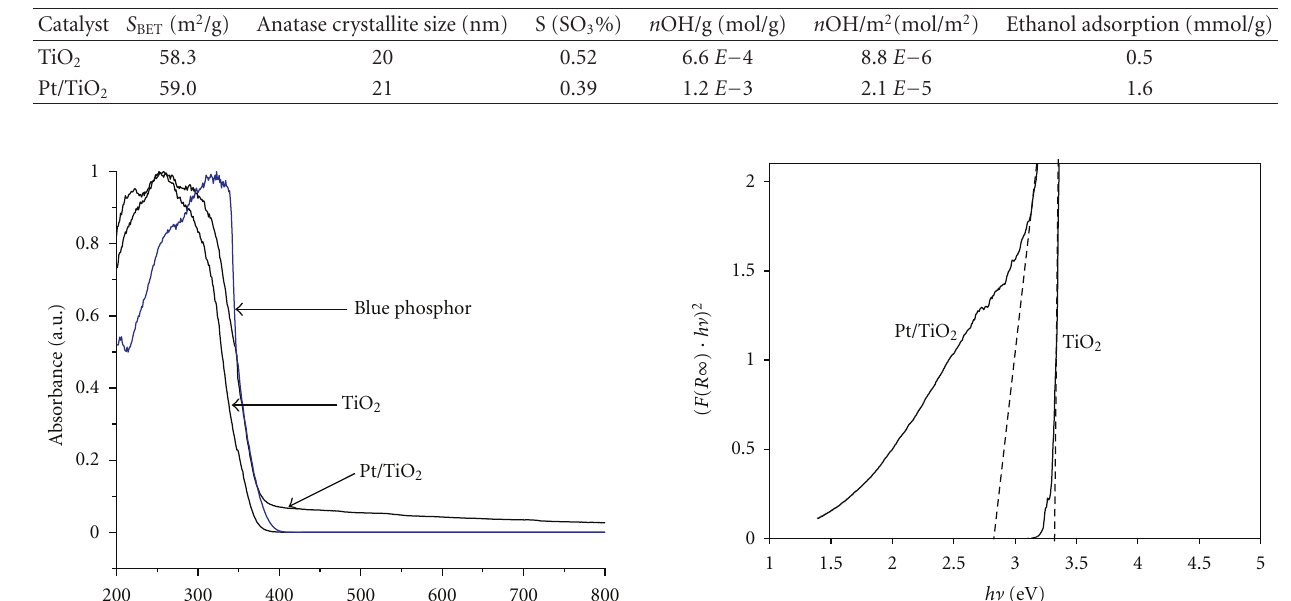
Table 1: Summary of characterization results.